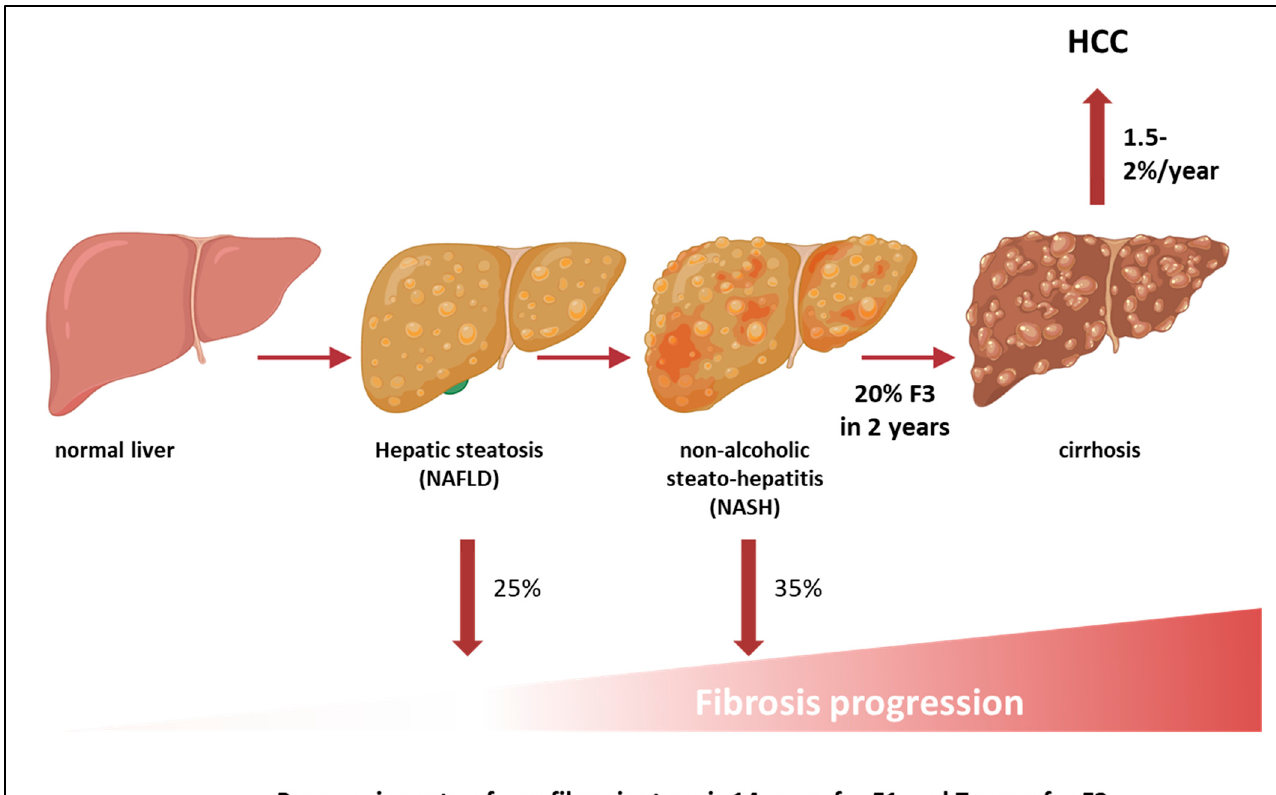
Figure 2. Natural history of NAFLD. NAFLD a ff ects almost 25% of the population worldwide. Up to 25% of patients with simple steatosis and up to 35% of patients with NASH may develop cirrhosis [32,43]. Overall, progression rate for one fi brosis stage is 14 years for F1 and 7 years for F3. However, a subgroup (20%) of patients with NASH and F3 may be fast progressors and develop cirrhosis in 2 years. The overall yearly incidence of HCC in those with NASH cirrhosis is 1.5–2%. The incidence of HCC among patients with non-cirrhotic NAFLD is lower, approximately 0.1 to 1.3 per 1000 pa-